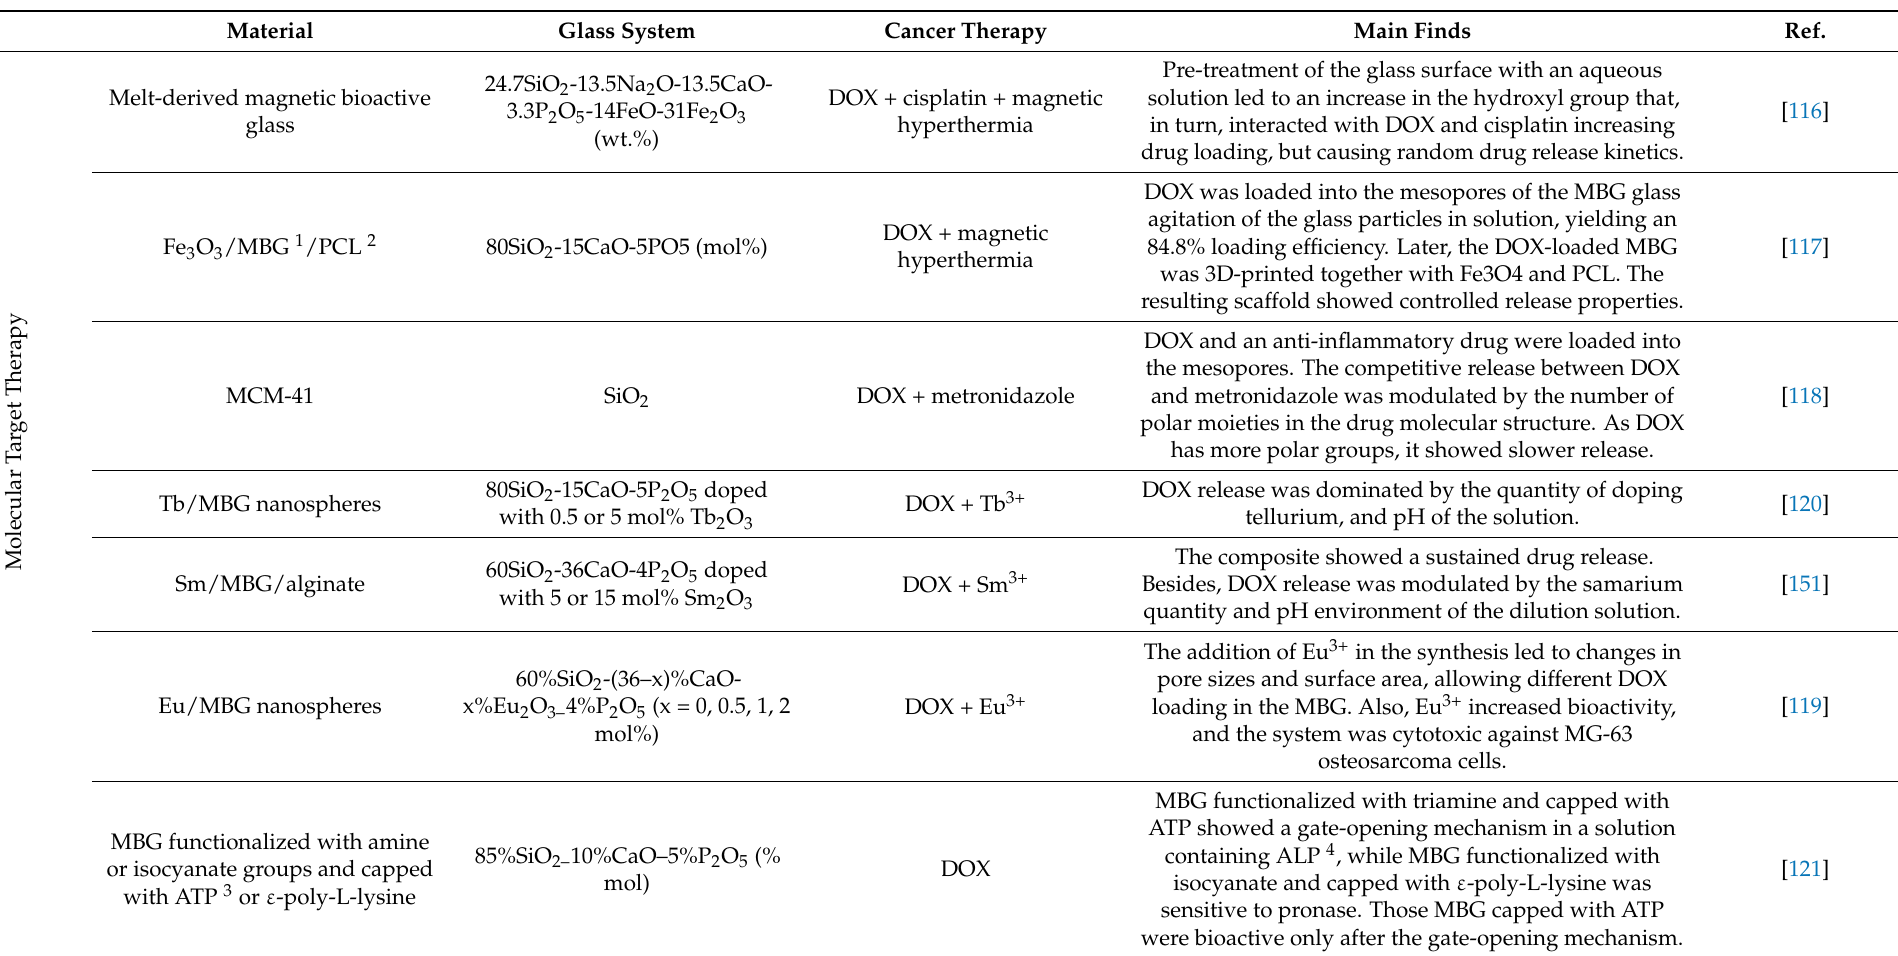
Table 1. List of main finds from the literature, cataloged in accordance with cancer therapy combined with bioactive glasses.